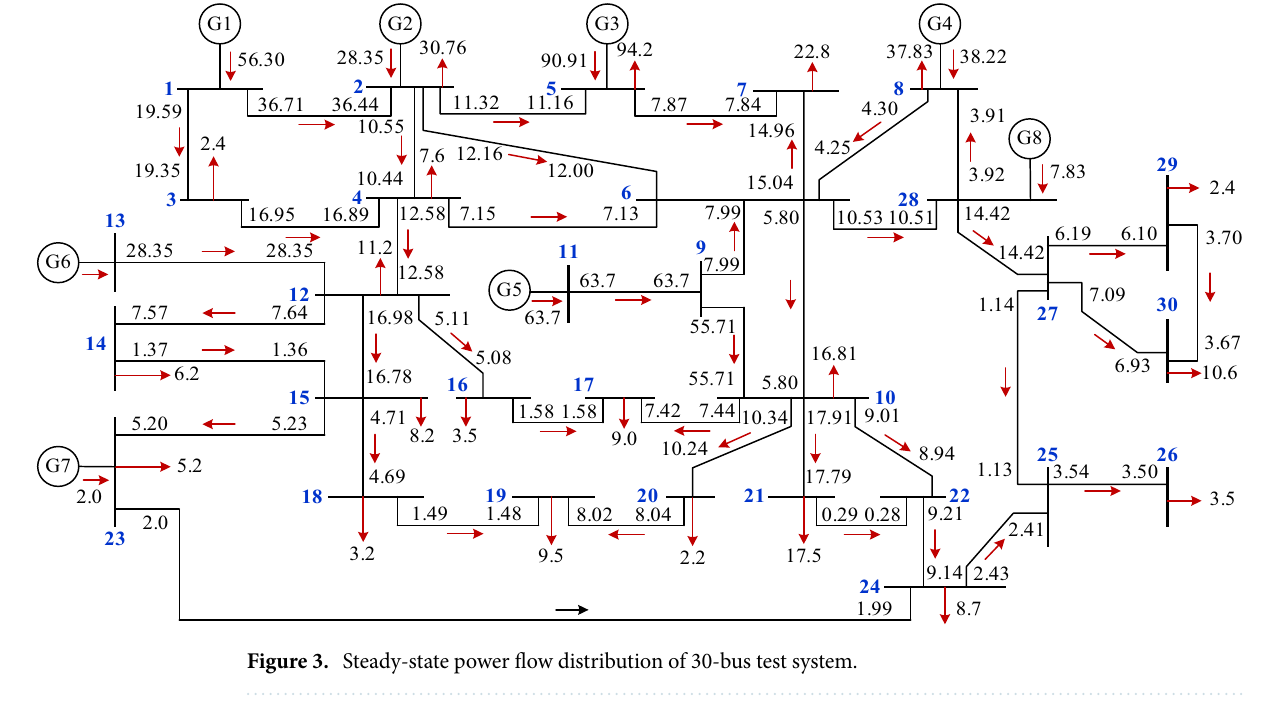
Figure 3. Steady-state power flow distribution of 30-bus test system.